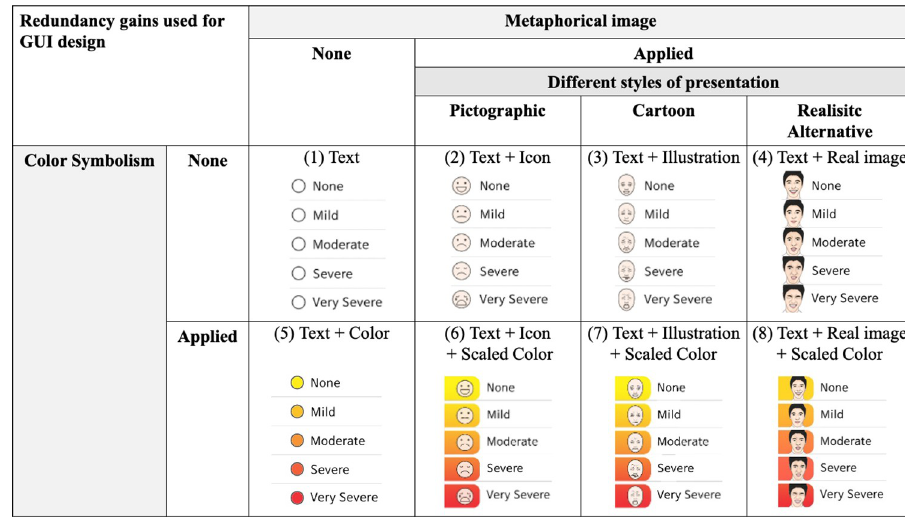
Fig 1. Graphical user interface (GUI) design to help understand the